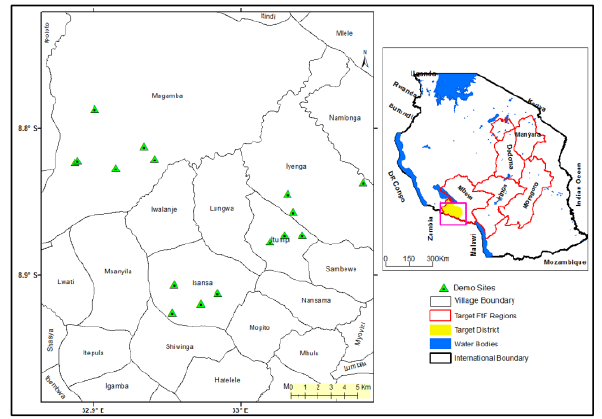
Figure 1. The location of trial sites for technology package comprising of an improved maize variety and inorganic fertilizers in Mbozi District, Mbeya region in Tanzania. The area with red boundary in the inset map show the projection domain targeted for extrapolation